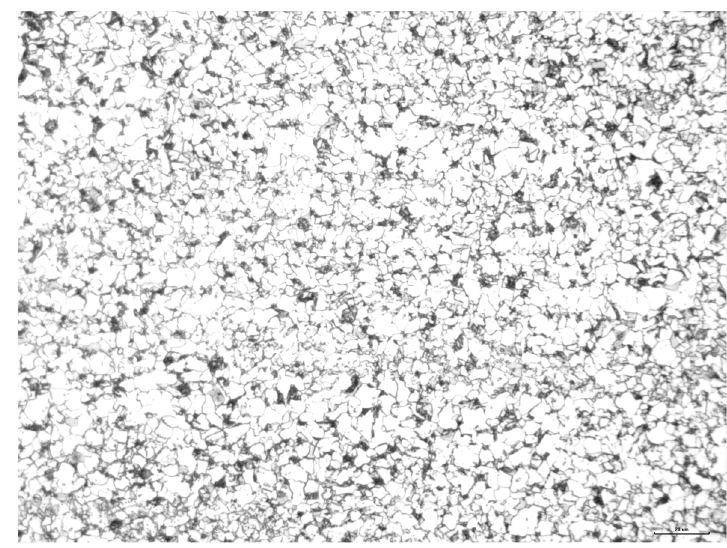
Fig. 13 Structure of fine-grained region